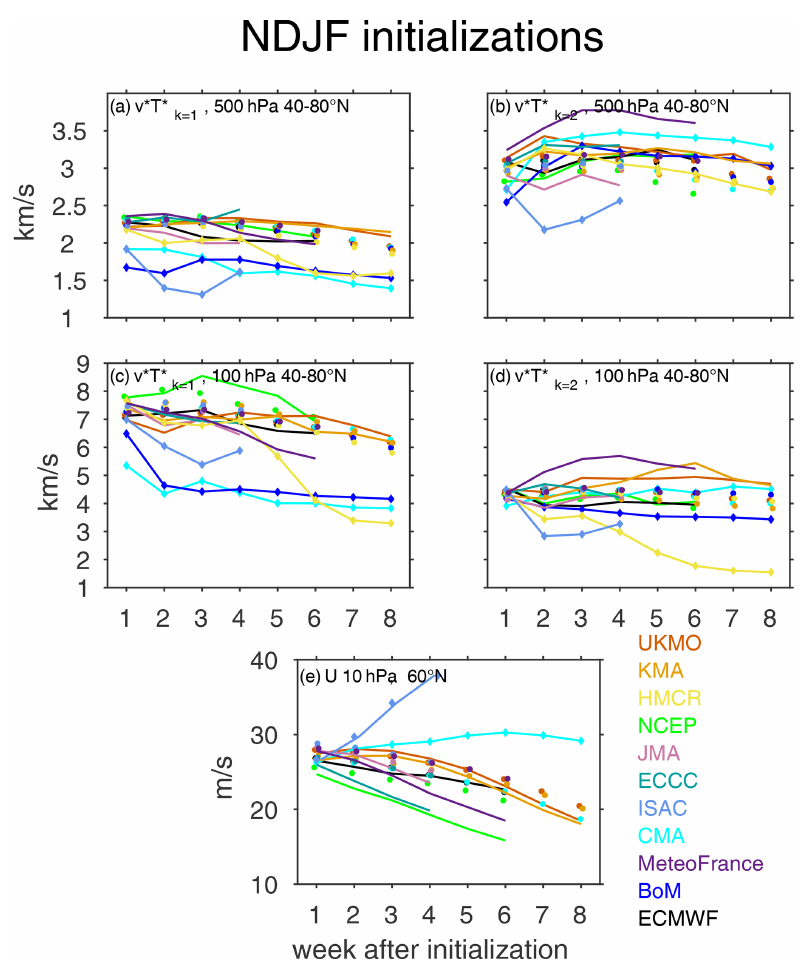
Figure 7. Time evolution of all integrations during November–December–January–February for S2S models (solid lines) and corresponding days from ERA-I (dots). (a) Mid-latitude wave 1 v ∗ T ∗ at 500hPa, (b) mid-latitude wave 2 v ∗ T ∗ at 500hPa, (c) mid-latitude wave 1 v ∗ T ∗ at 100hPa, (d) mid-latitude wave 2 v ∗ T ∗ at 100hPa, (e) zonal-mean zonal wind at 10hPa at 60 ◦ N. Low-top models are indicated with diamonds on the